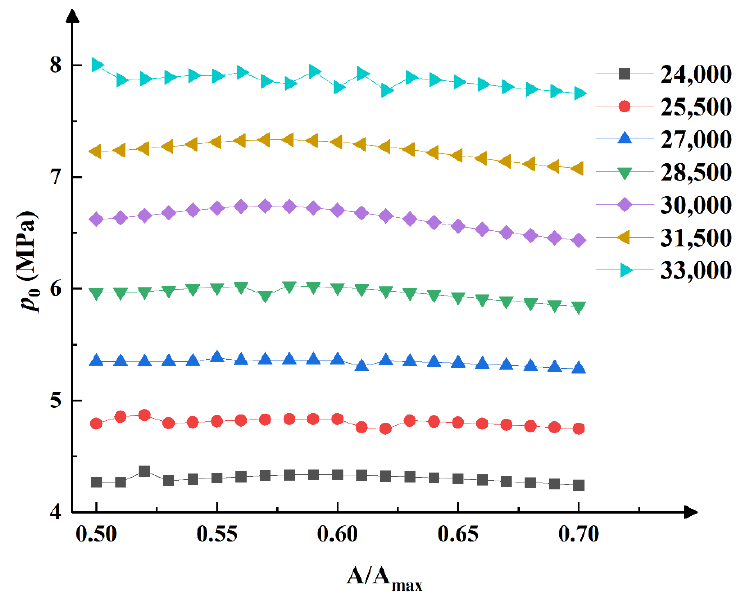
Figure 13. Pressure of pump outlet vs. speed and valve opening under medium operating conditions.